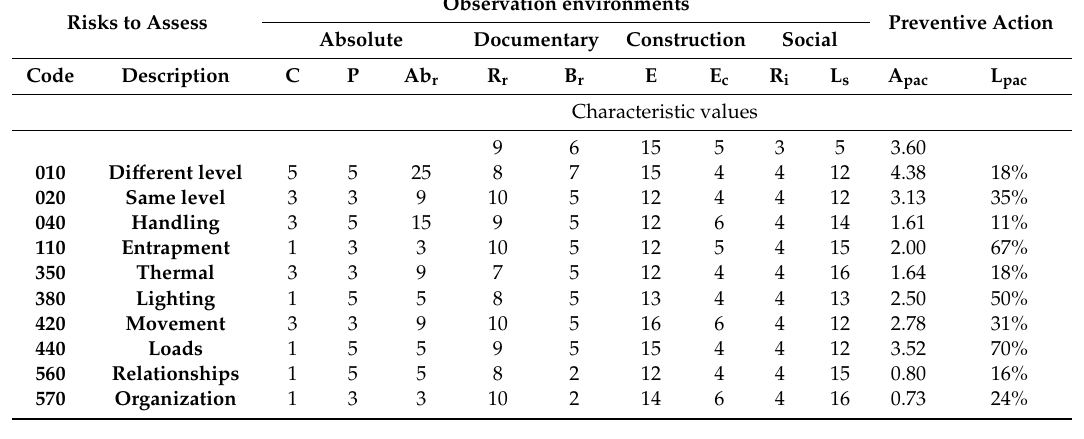
Table 10. Example of risk impact calculation.